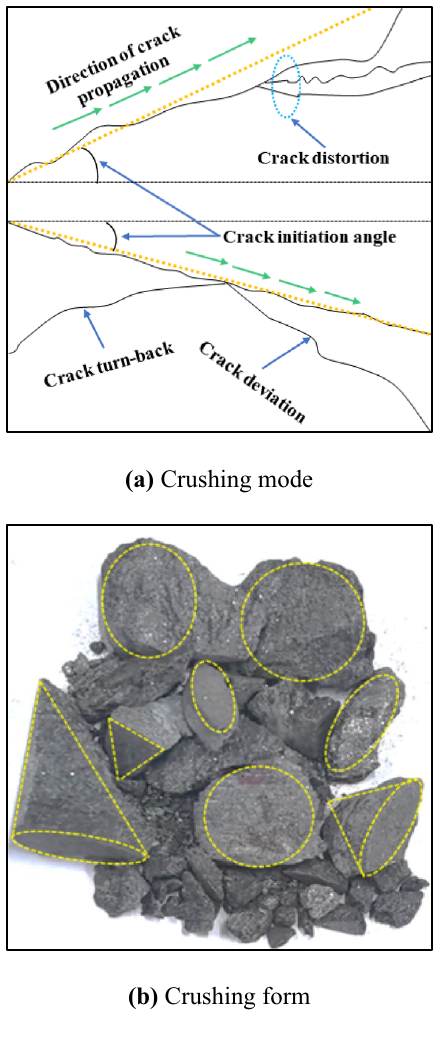
Figure 7. Schematic diagram of crushing mode and crushing form ( a ) crushing mode; ( b ) crushing form.